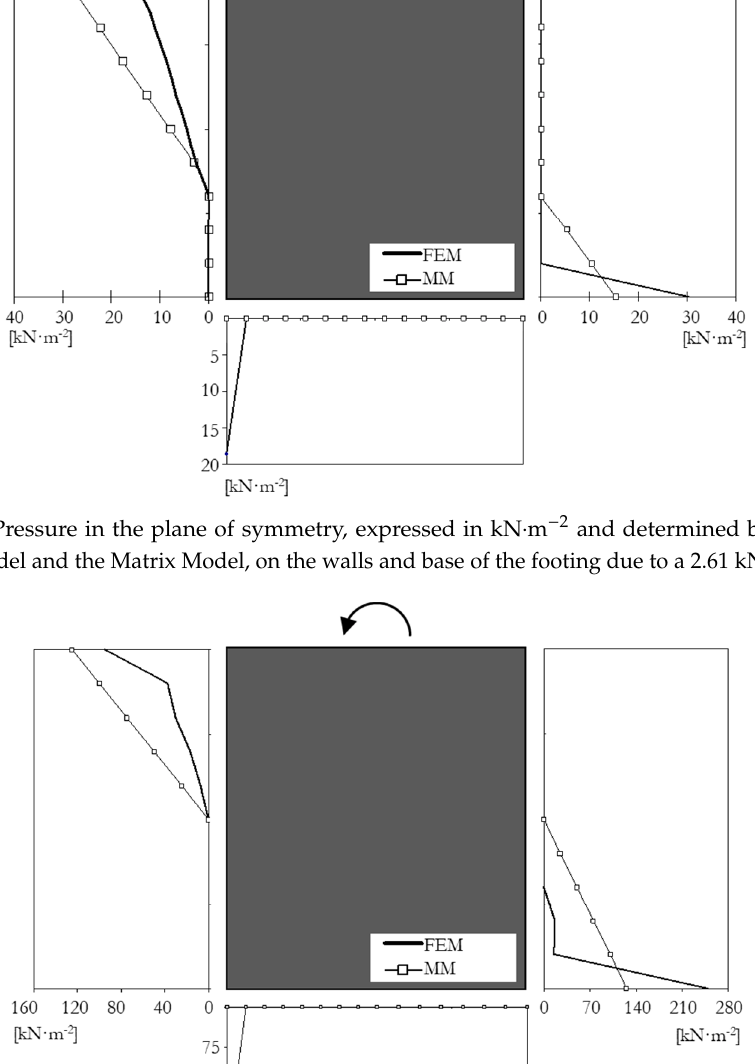
Figure 26. Pressure in the plane of symmetry, expressed in kN·m − 2 and determined by the Finite Element Model and the Matrix Model, on the walls and base of the footing due to the simultaneous application of axial, shear and moment stresses. As shown in Figure 27, both horizontal and vertical deformations are commonly overestimated in matrix methods. On the top of the footing, the horizontal displacement was − 3.560·10 − 3 m for the MM, whereas values of 0.251·10 − 3 m and − 0.0276·10 − 3 m were detected on the left and right-end points (i.e., points 1 and 2, respectively, in Figure 27a) according to FEM calculations. A similar pattern was observed for the horizontal displacements on the bottom of the footing. Meanwhile, the FEM results